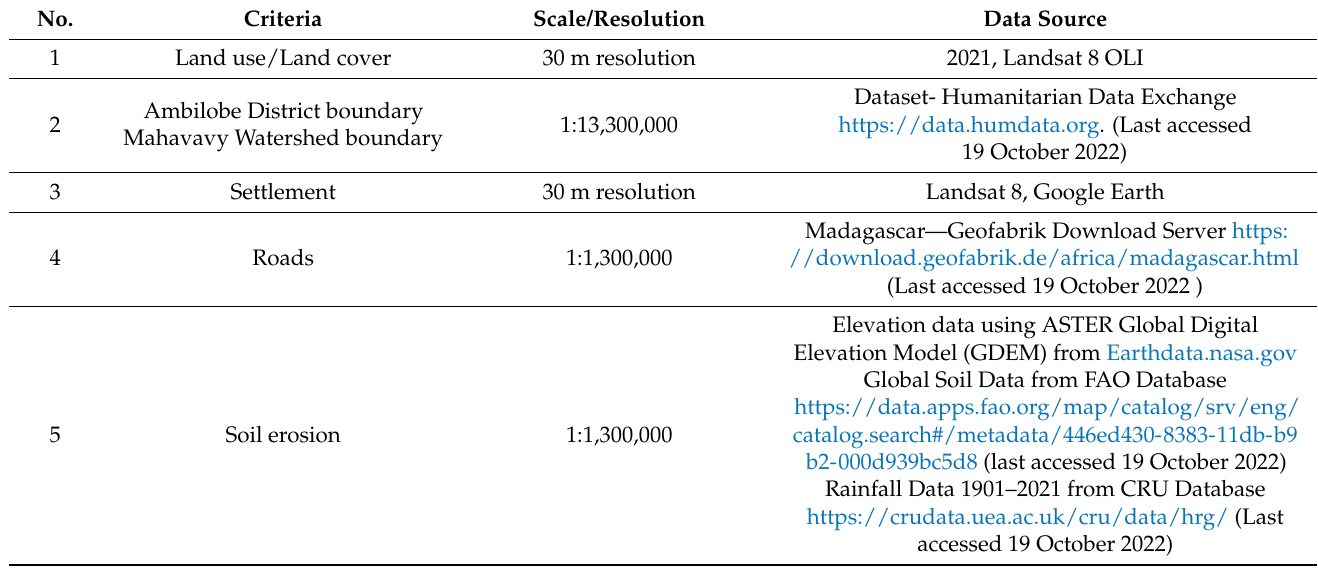
Table 1. Satellite and GIS datasets for land suitability analysis for extension of potential forest areas in northwest Madagascar